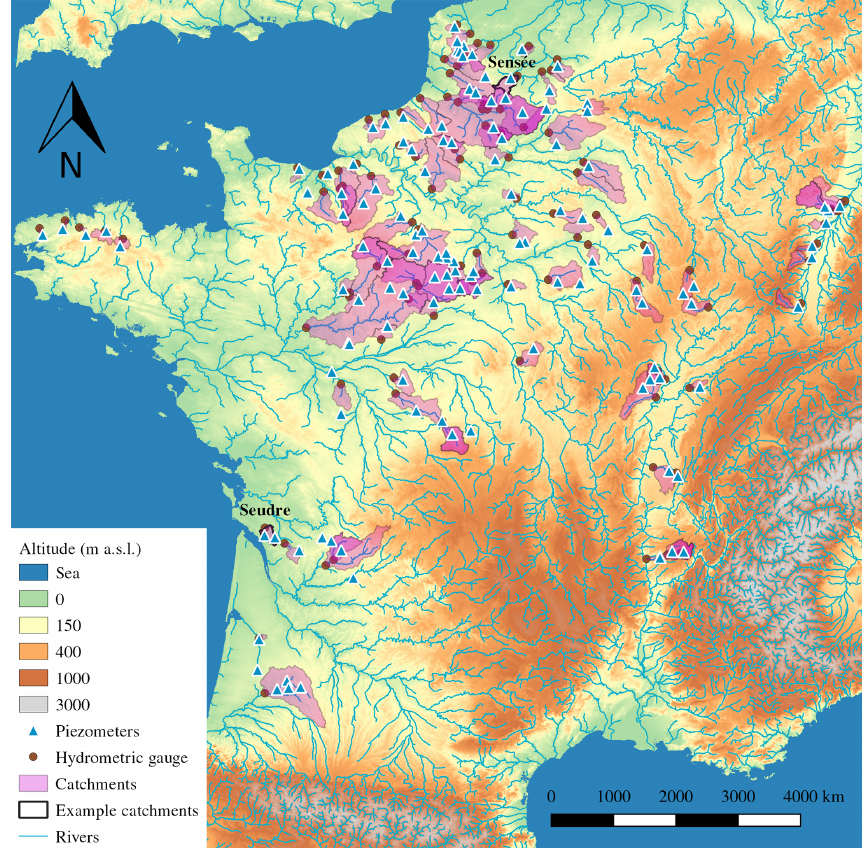
Figure 3. Map of the catchments and the piezometer dataset. The example catchments of Fig. 2 are shown.